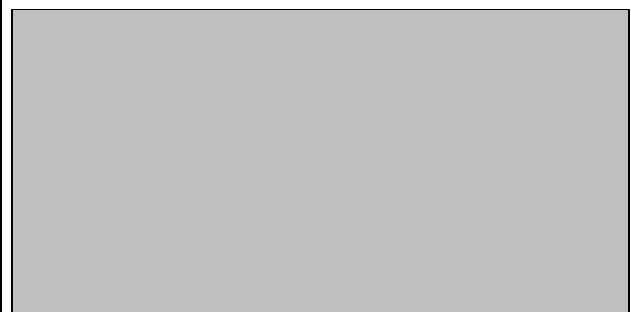
Table II : General information about lung and colon cancer subjects for some categorical